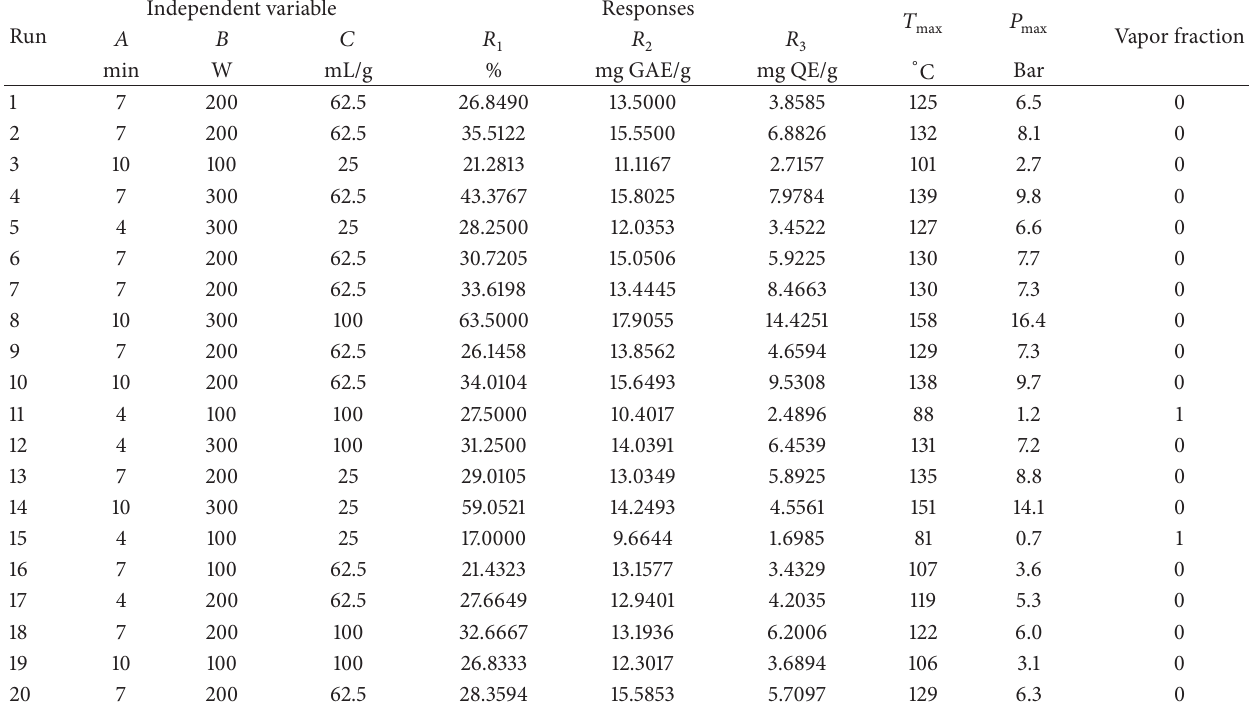
Table 1: Experimental design for the extraction process obtained from central composite design (CCD) and corresponding